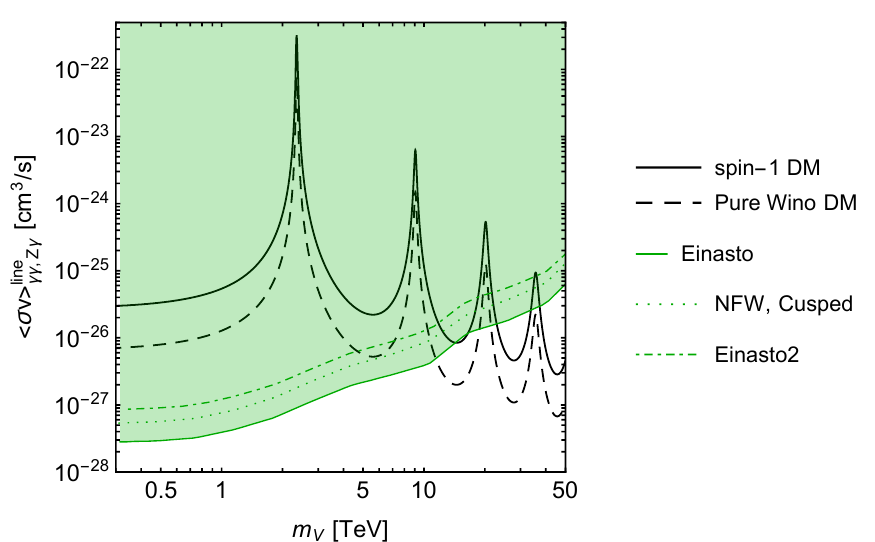
Figure 1 . The comparison of the line cross sections between our spin- 1 DM and the Wino DM. line The solid (dashed) black curve shows h σv for our model (pure Wino). The green shaded rel i γγ,Zγ region shows the constraint from the H.E.S.S. observation in the Galactic Center region [32] for the Einasto profile [33]. The green dotted curve and dashed curve show the upper limit for the NFW profile [35] and Einasto2 profile [34], respectively. The upper bound is expected to be weakened by a factor of O (10 − 100) for the cored DM density